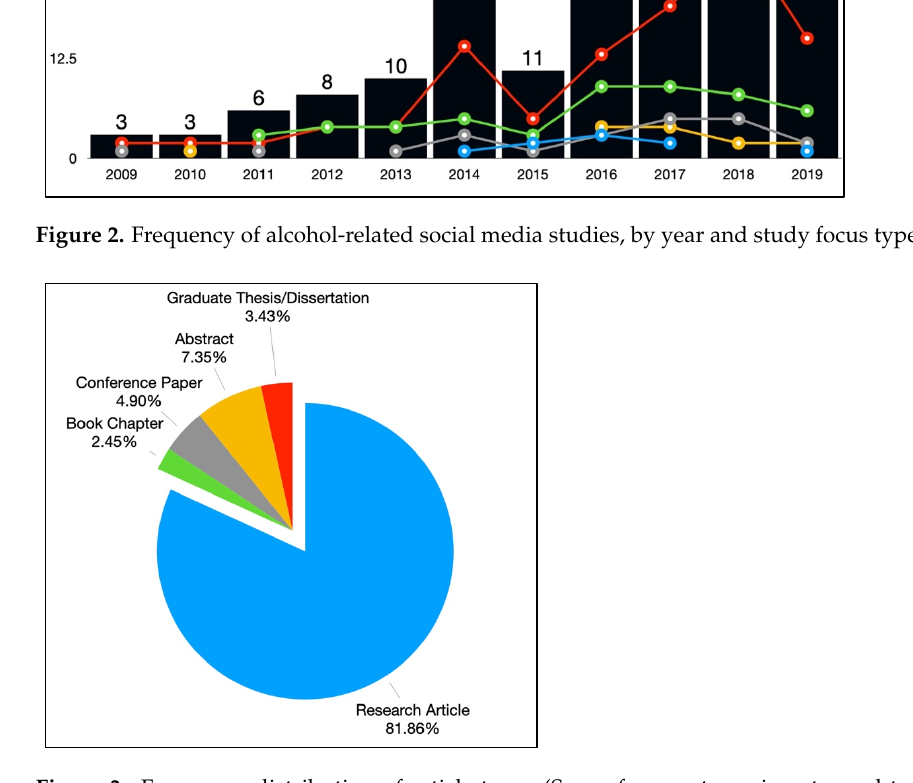
Figure 2. Frequency of alcohol ‐ related social media studies, by year and study focus type.